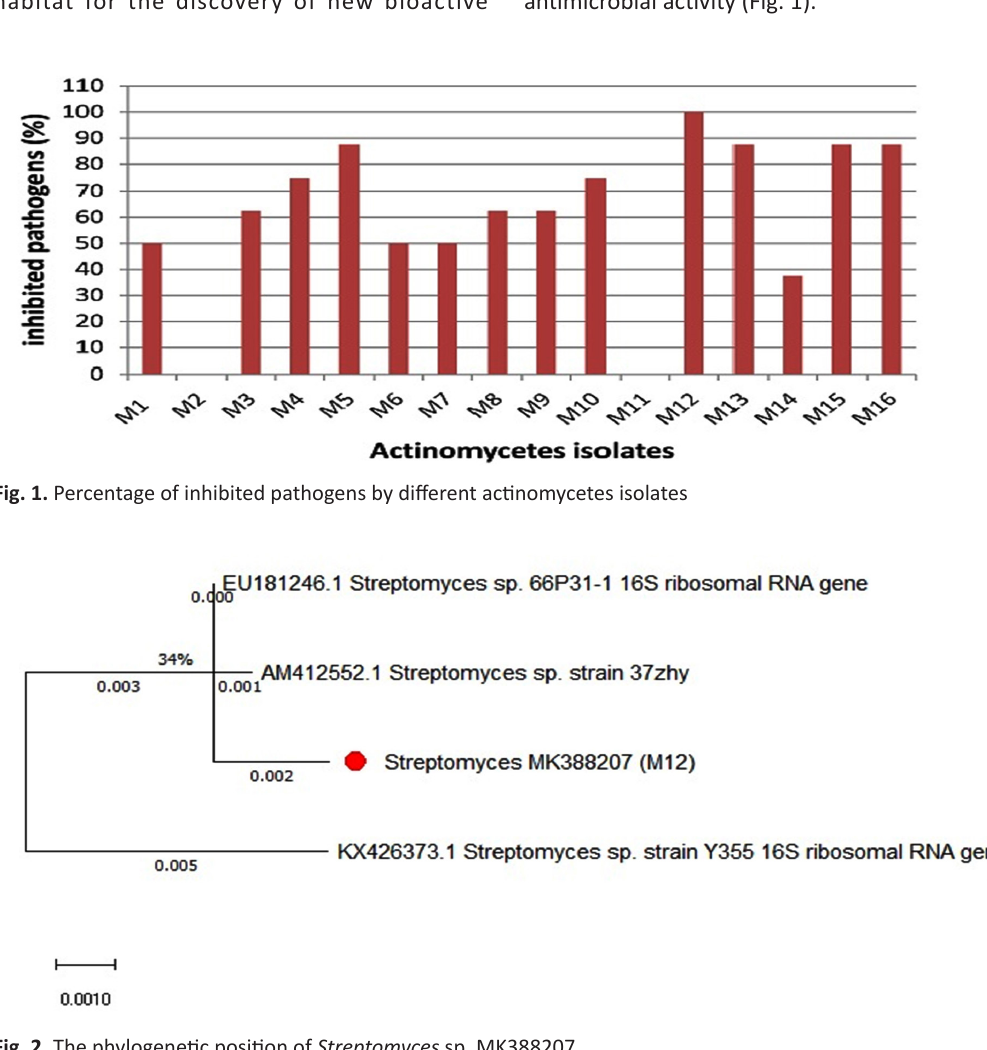
Fig. 2. The phylogenetic position of Streptomyces sp.